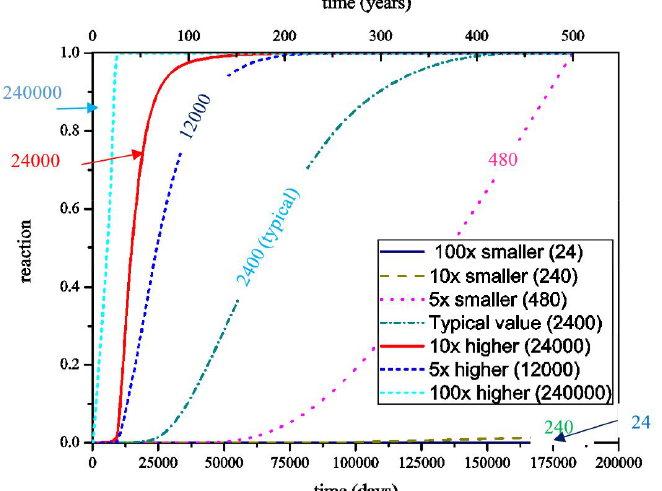
Figure 6. Parametric analyses, results for reaction field over time – Initial CO 2 diffusivity (values in mm 2 /day) (time of study: 0 to 500